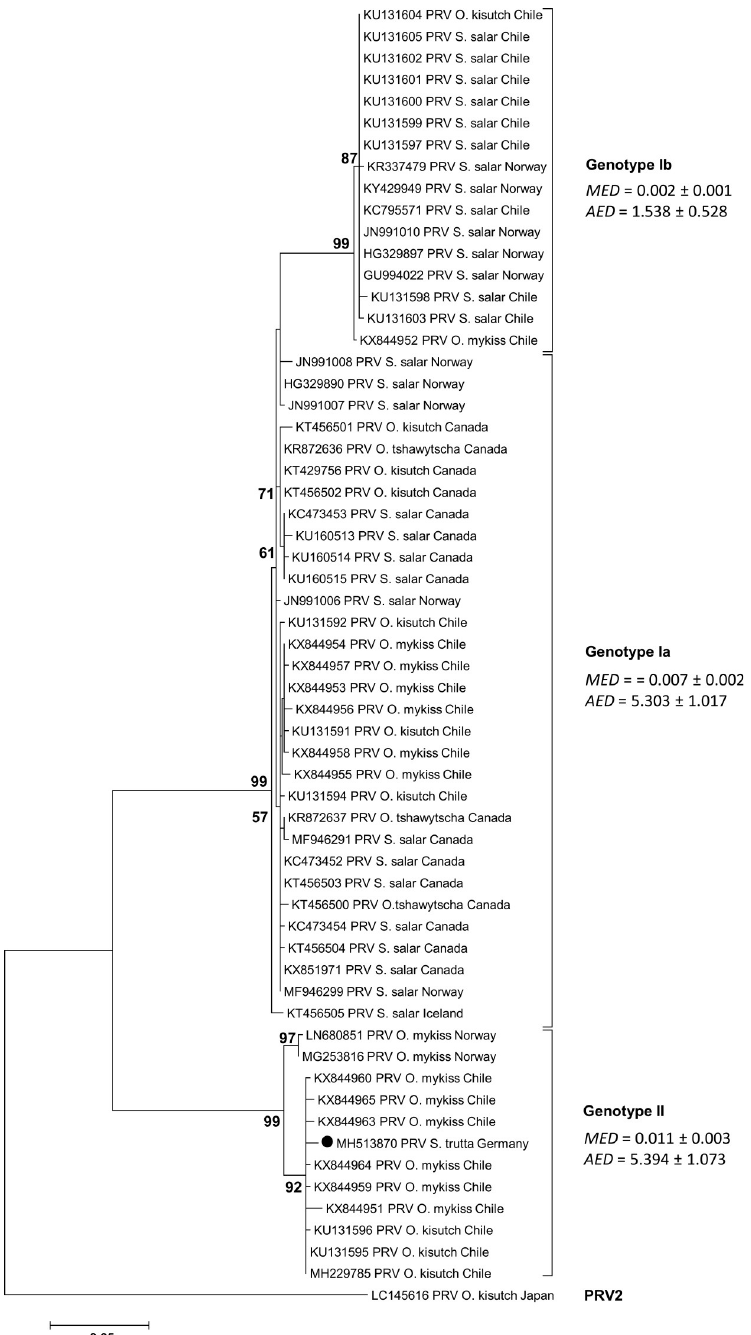
Fig 3. Phylogenetic analysis based on generated S1 sequence of the PRV-S1 from S . trutta , Germany, and sequences of the piscine reovirus downloaded from NCBI database. For each sequence the current GenBank accession number as well as the location where the virus was detected is shown. The scale bar (left below) refers to substitutions per amino acid sites. Numbers on the nodes represent the confidence limits ( > 50%) estimated from 100 bootstrap replicates. The cluster definition (Genotype Ia, Ib, II and PRV 2) is displayed according to Takano et al. [40]. For every cluster the mean evolutionary diversity ( MED ) and the average evolutionary divergence ( AED ) was computed with MEGA7 [34]. The sequence of this study is symbolized by a solid